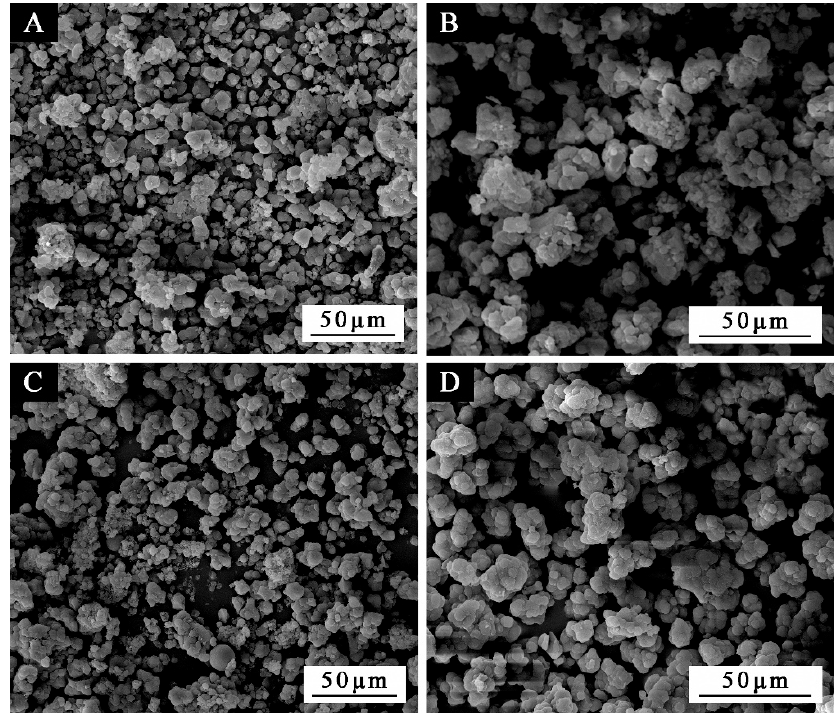
Figure 3. The SEM morphologies of microcapsules under different orthogonal experimental param- eters: ( A ) sample 1#, ( B ) sample 2#, ( C ) sample 3#, ( D ) sample 4#.